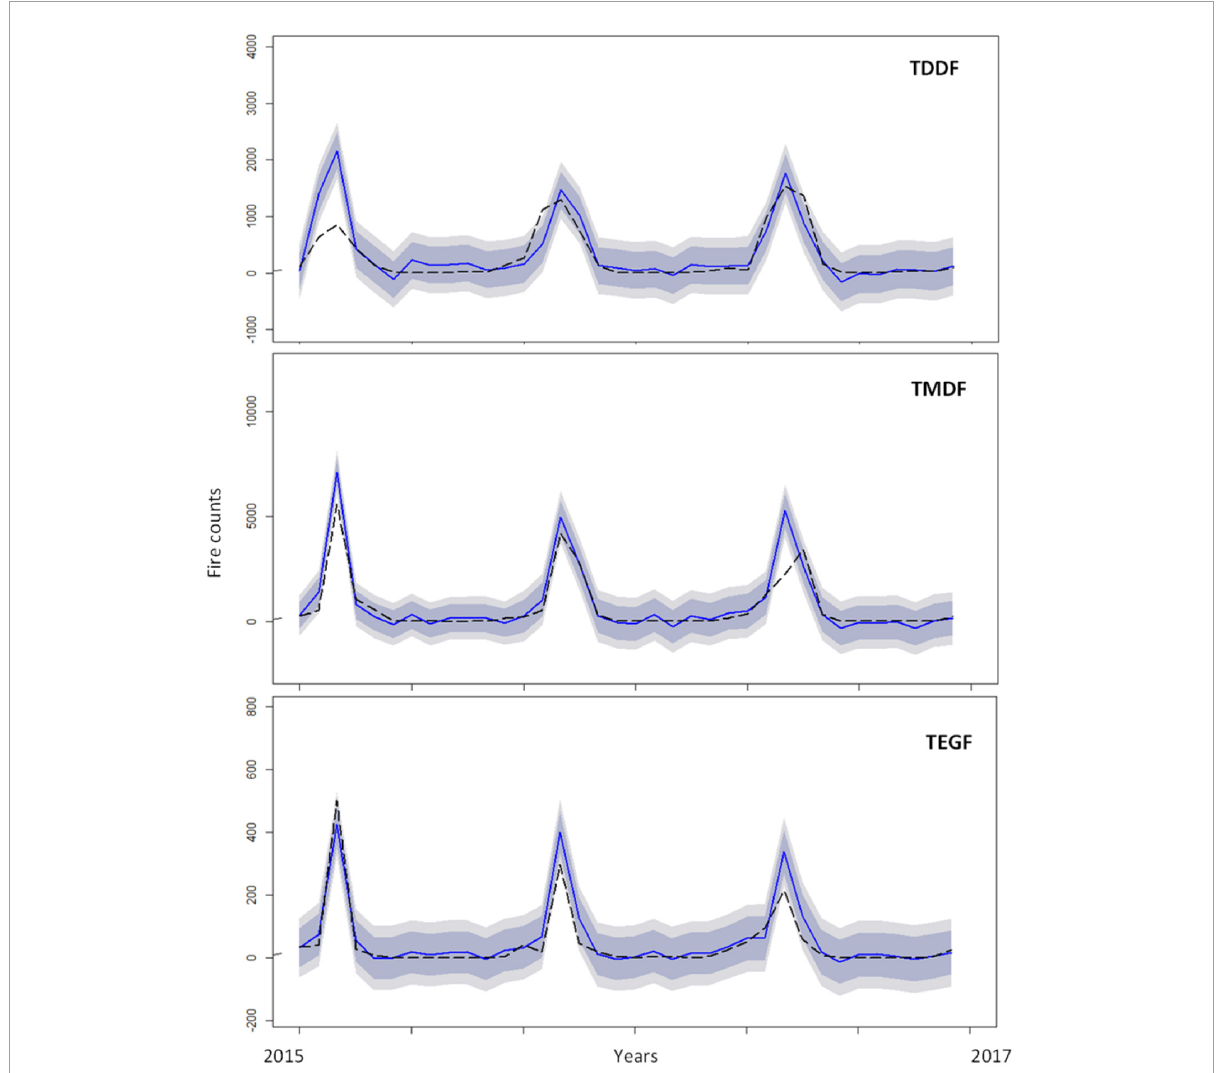
FIGURE10 Comparison of ARIMA with regressors (temperature and dry days) model with test data (2015–2017) for Tropical Dry Deciduous Forests (TDDF), Tropical Moist Deciduous Forests (TMDF), Tropical Evergreen Forests (TEGF). The dotted line depict the original values, solid blue line depicts forecasted values and shaded area depicts prediction interval (inner to outer 80 and 95%,